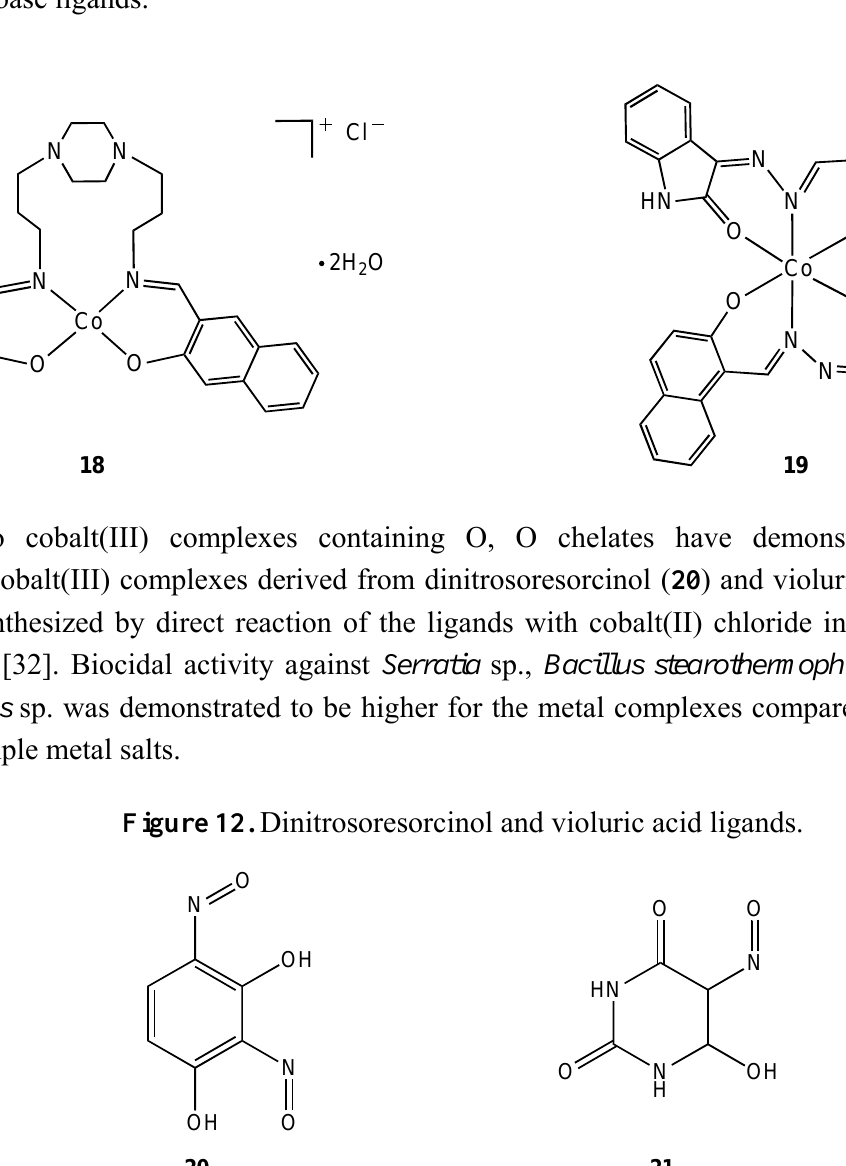
Figure 11. Tetragonal and octahedral cobalt (III) complexes containing N, O chelating Schiff base ligands.